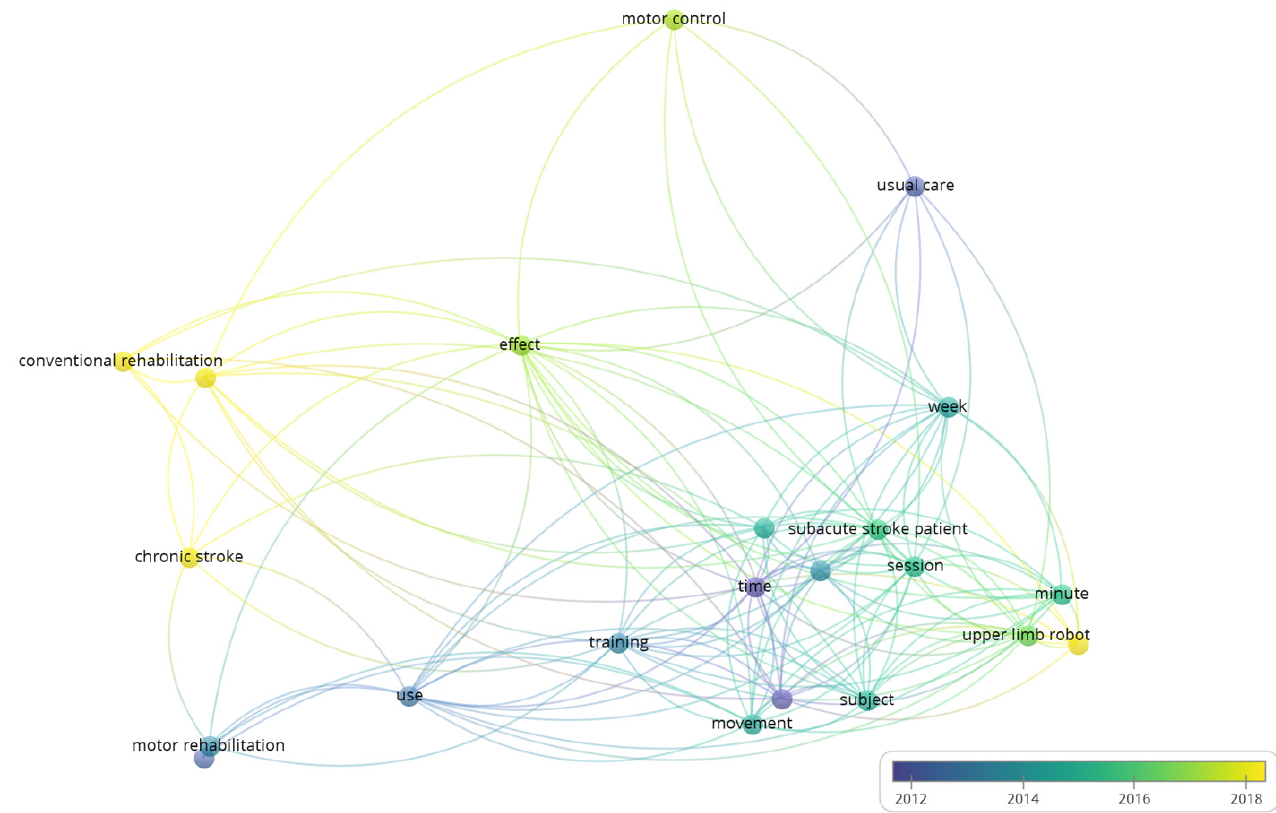
Figure 4. Overlay visualization of key items coincident analysis. The map was constructed by VOSViewer software from the identified 18 studies. The incidences of each key item determined the size of the circle. The colors of the circles indicated the score of the key item since publication according to the color scale.